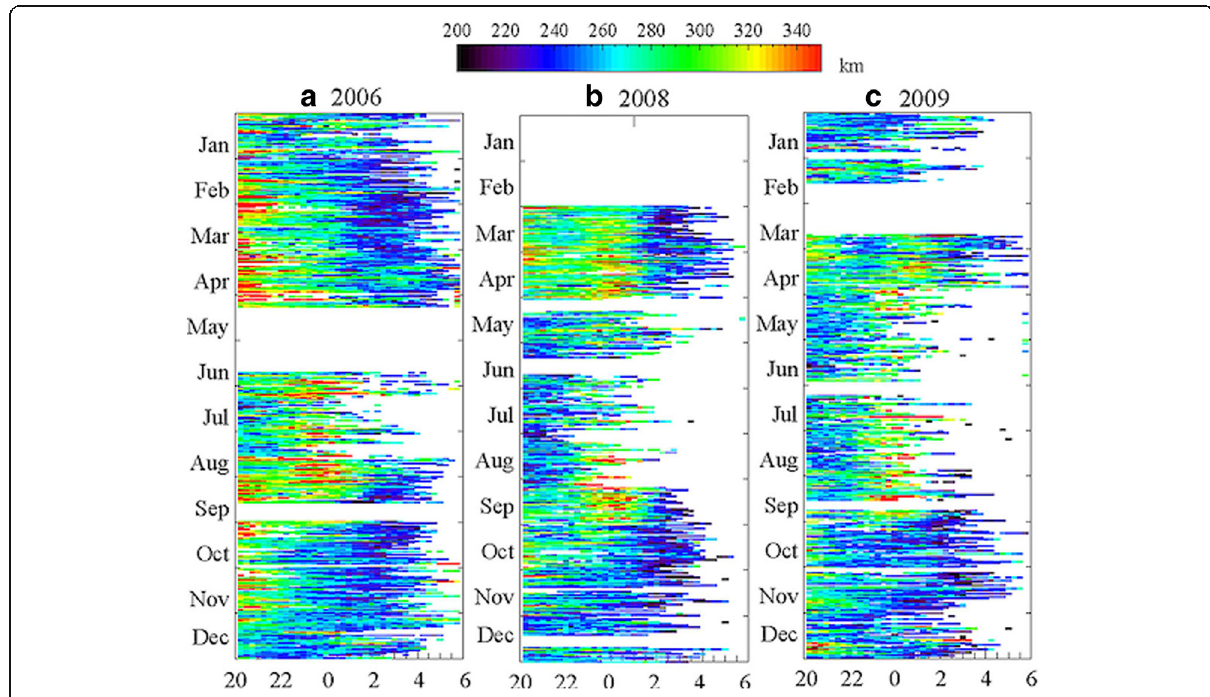
Fig. 10 Seasonal and local time variations of hmF2 at Chumphon in ( a ) 2006, ( b ) 2008, and ( c ) 2009 (after Nishioka et al. 2012)